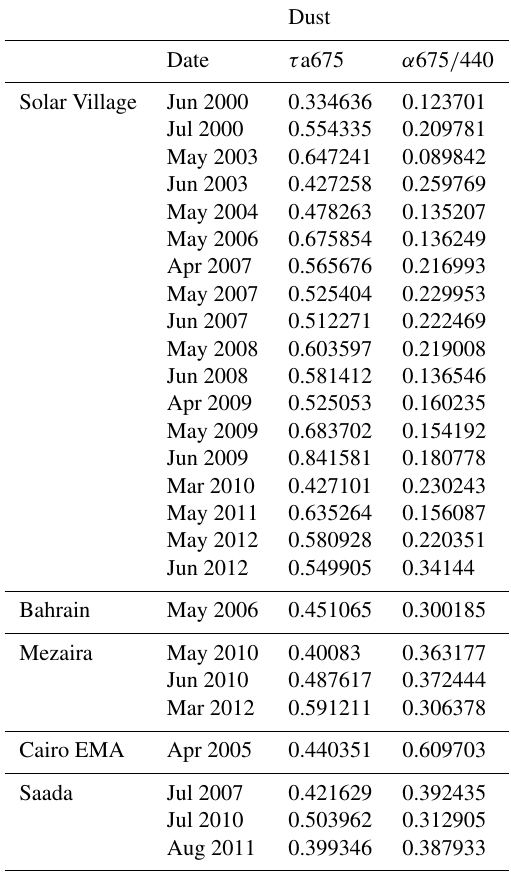
Figure 3. Absorption aerosol optical depth ( τ abs ) average grouped by the dominant aerosol type at the eight sites using AERONET Version 2, Level 2.0 data retrievals: (a) Solar Village, Bahrain, and Mezaira; (b) Tamanrasset, Saada, Ben Salem, and Sedé Boqer; (c) Cairo.